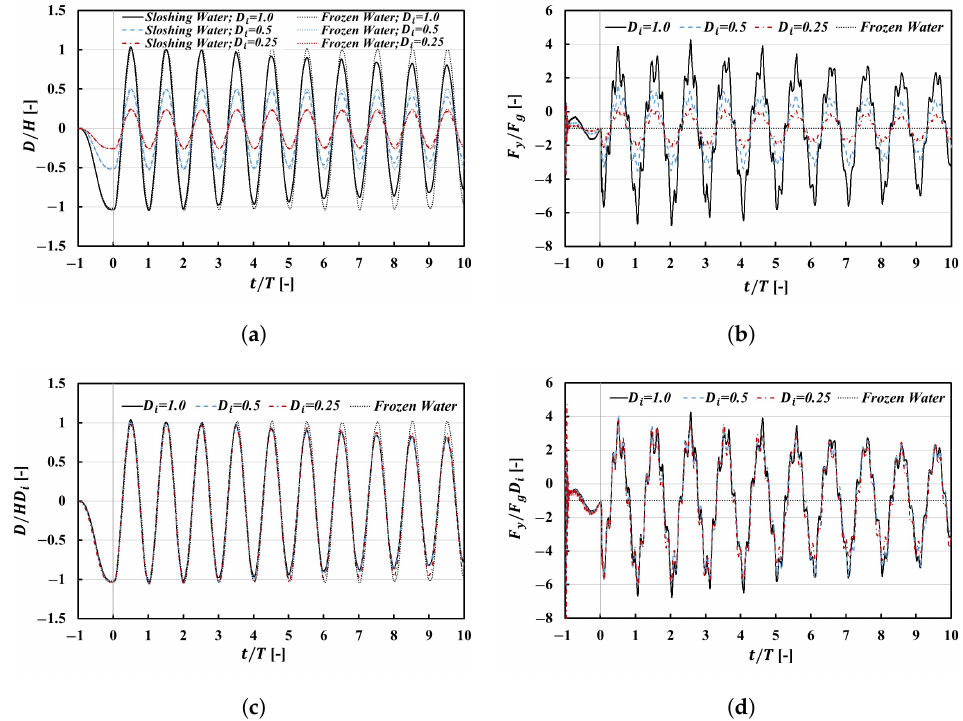
Figure 5. Time history of non-dimensional ( a , c ) tip vertical displacement and ( b , d ) vertical fluid force of the system over ten oscillation cycles with one compartment, in which ( c , d ) are normalised by the initial excitation amplitude.